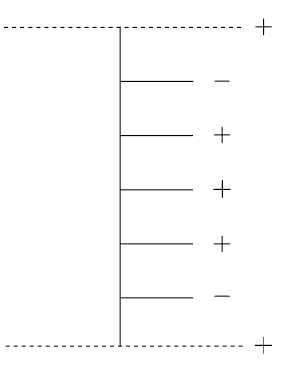
Figure 4 . Region % 9 ; 5